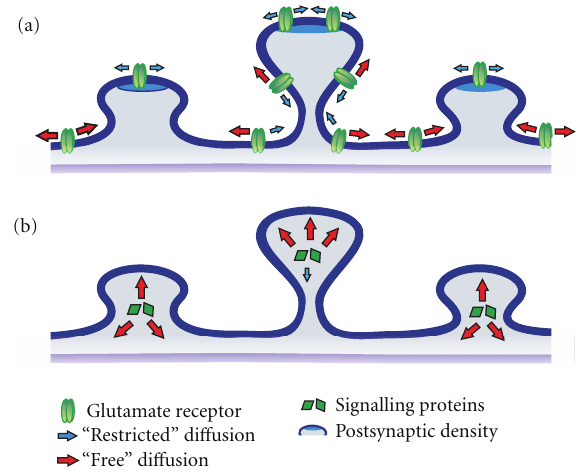
Figure 1: Biochemical compartmentalization in dendritic spines. The spine neck may o ff er enhanced compartmentalization of biochemical signalling at synapses. (a) The lateral mobility of surface glutamate receptors is attenuated across longer spine necks and at the postsynaptic density. (b) The spine neck imposes di ff usional constraints on cytosolic signalling proteins. These mobility restraints imposed by the spine neck create spine-specific compartmentalization of cytosolic signalling and surface receptor